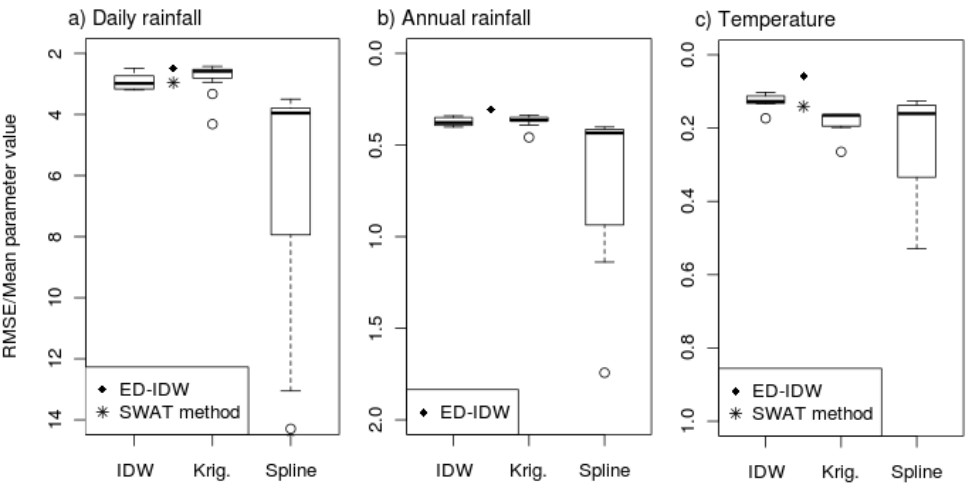
Fig. 2. Boxplots of interpolation errors (Root Mean Square Error, RMSE) obtained with different univariate algorithms for daily rainfall (a) , annual rainfall (b) and temperature (c) , compared to the elevation-dependent algorithm chosen for preprocessing modelling inputs (ED-IDW) and the method internally used by SWAT.